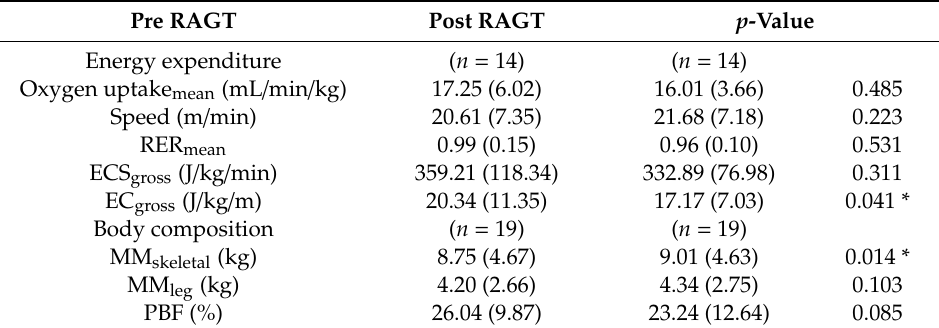
Table 4. E ff ect of RAGT on energy expenditure and body composition.